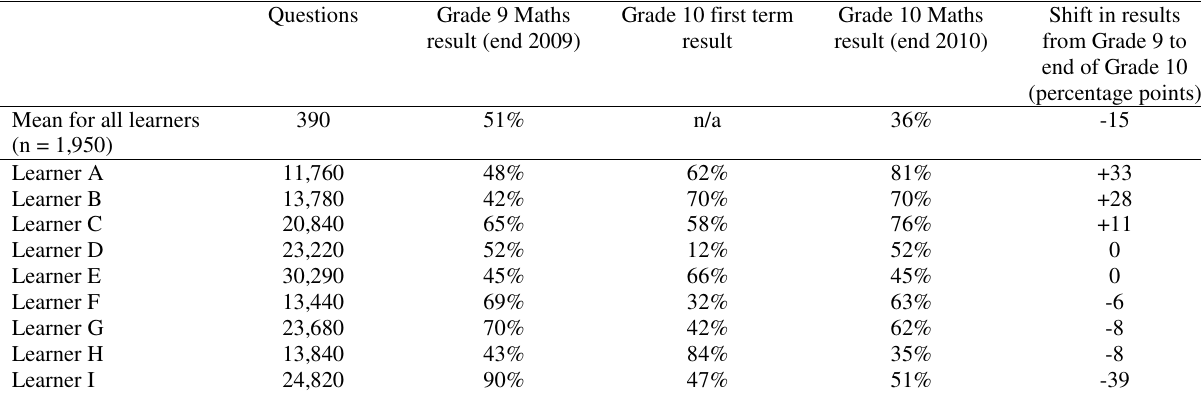
Table 3 Shift in results for exceptional users (n =